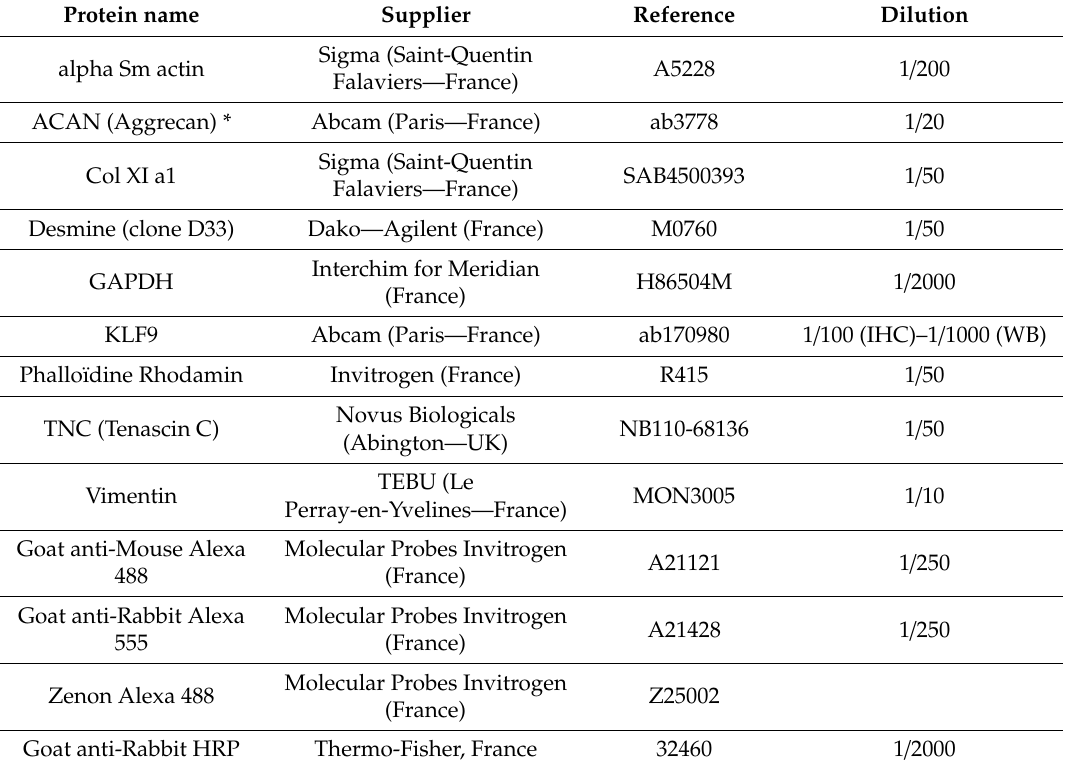
Table 2. Antibodies. Antibody references and working dilutions are